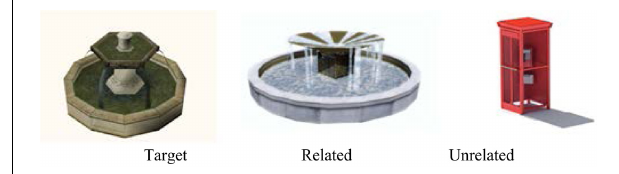
FIGURE 3 | Example of the three types of pictures used in the visual recognition task: target (the fountain encountered during the route), related distractor (another fountain that was visually different), unrelated distractor (an entity that was verbally and visually different from the target). FIGURE 4 | Example of a picture in the direction-choosing